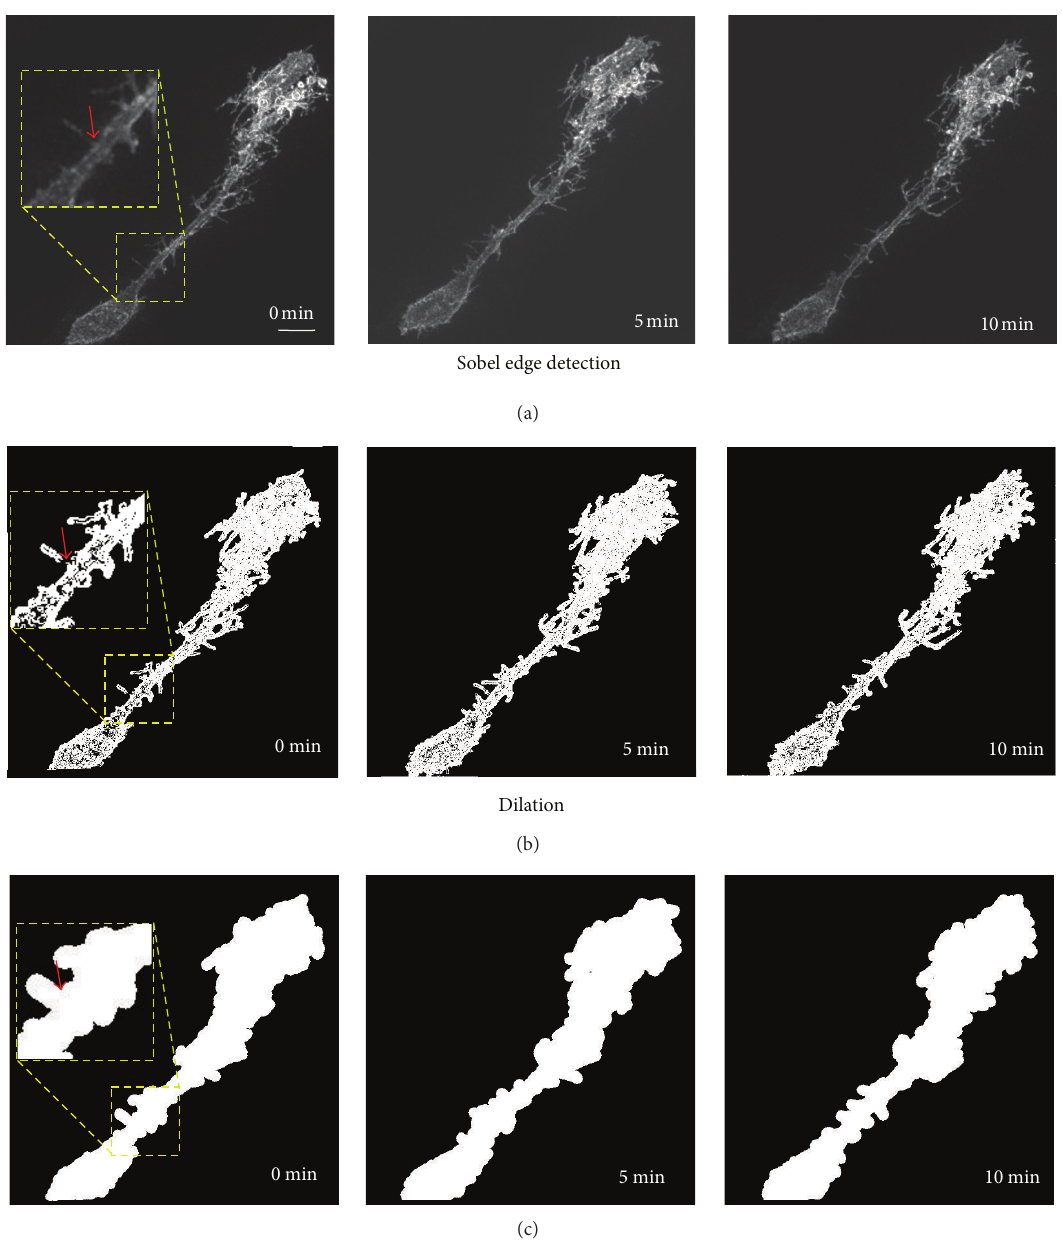
Figure 2: Image preprocessing for analysis. (a) Maximum intensity projections of two-photon images of a radial glia cell expressing farnesylated EGFP in vivo collected at 0, 5, and 10 minutes. (b) Same images after Sobel edge detection and binarization. (c) Binarized images underwent dilation with a 6-pixel radius. Pixel dilation helps eliminate artifactual discontinuities in the images (arrowhead in insets) resulting from the binarization step. Scale bar = 10 𝜇